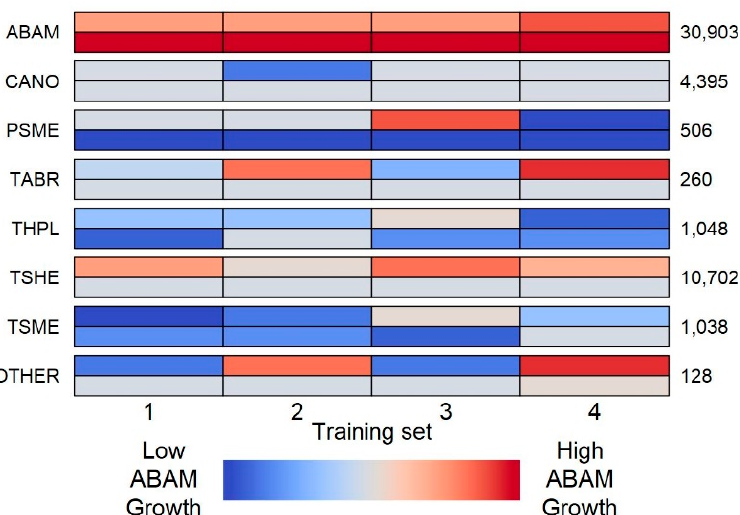
Figure 1. Which neighbor species are associated with the highest/lowest growth of ABAM focals? For each neighbor species, there are two rows of colored bars. The top row of bars shows the likelihood model results, and the bottom row shows the regularized regression model results. Each row of bars is divided into four sections, to show the results according to the models fitted to each of the four training sets. The color of the bars indicates the growth rate of ABAM in the presence of the neighbor species that row represents (see inset legend). The numbers on the right of the figure indicate the number of neighbors of each species averaged across training sets.